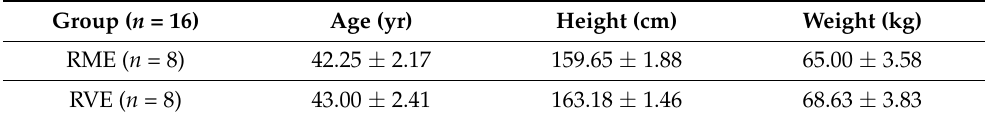
Table 1. Participant